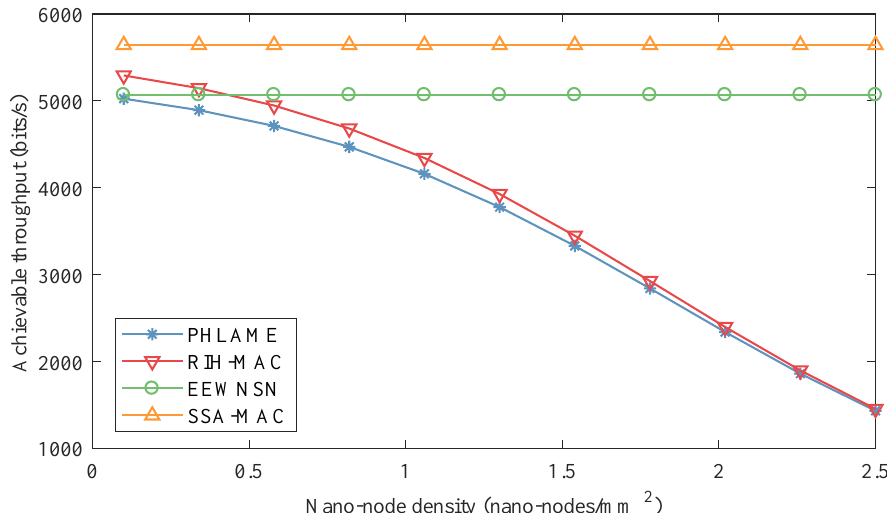
Figure 9. Achievable throughput of different MAC protocols as a function of nano-node density in centralized nano-networks.